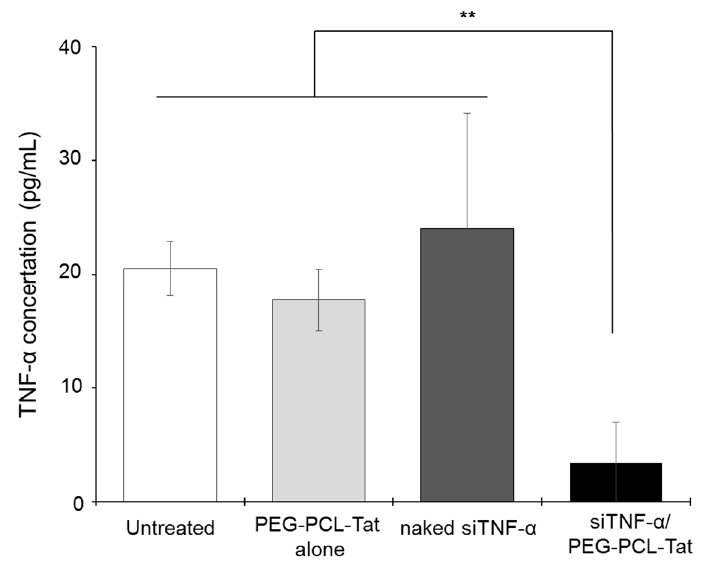
Figure 4. The TNF- α concentration in the brain of MCAO rats treated with intranasal administration of siTNF- α / PEG-PCL-Tat complex. Each left brain from MCAO rats in each treating group was isolated and homogenized. The TNF- α concentration in the supernatant of centrifuged homogenate was determined was measured by ELISA kit. Each bar represents the mean ± S.E. ( n = 5). ** p < 0.01.